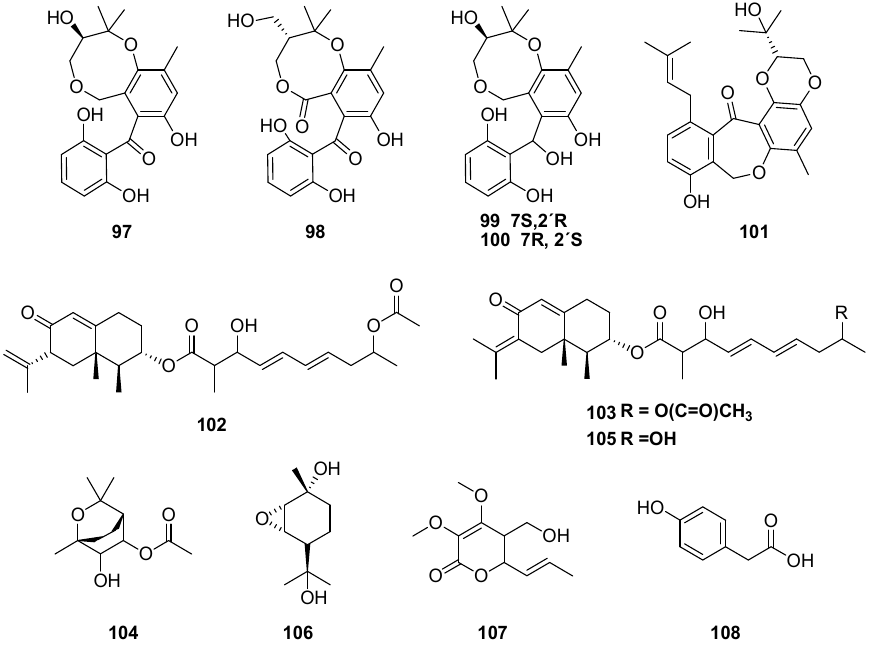
Figure 9. Compounds extracted from endophytic fungi, Cytospora rhizophorae and Diaporthe lithocarpus obtained from M. officinalis.